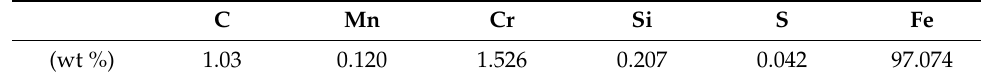
Table 1. Chemical composition of SAE 52100 hardened steel [37].